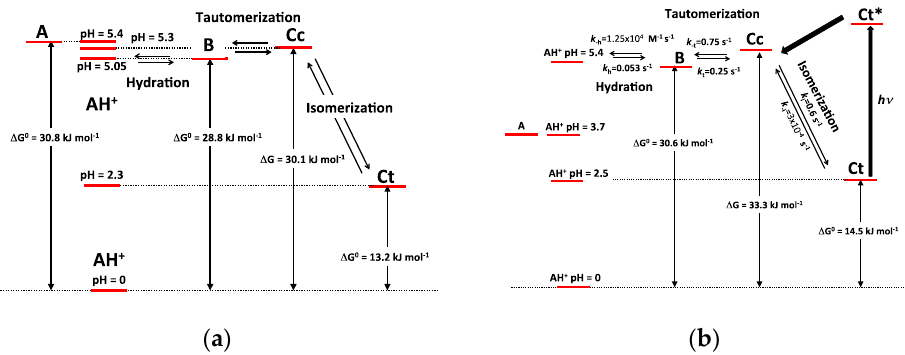
Figure 11. Energy level diagrams of P3 ( a ) and P5 ( b ). *: Excited state.